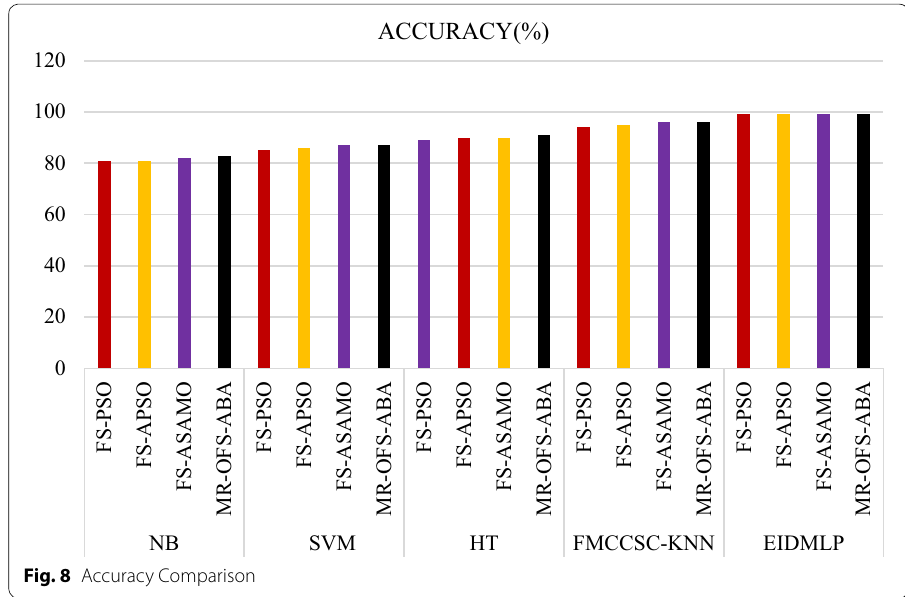
Fig. 8 Accuracy Comparison